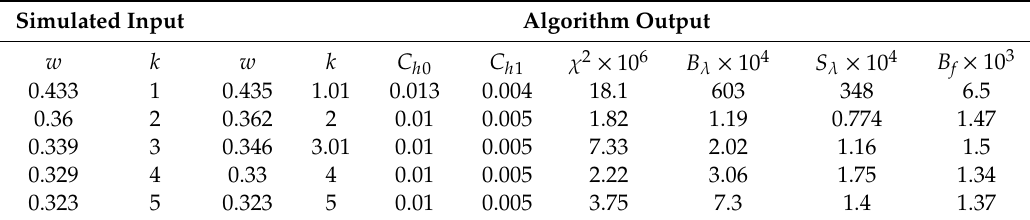
Table 6. Sensitivity results of the updated algorithm (including SRF parameters) applied to solar irradiances convolved with di ff erent SRFs.